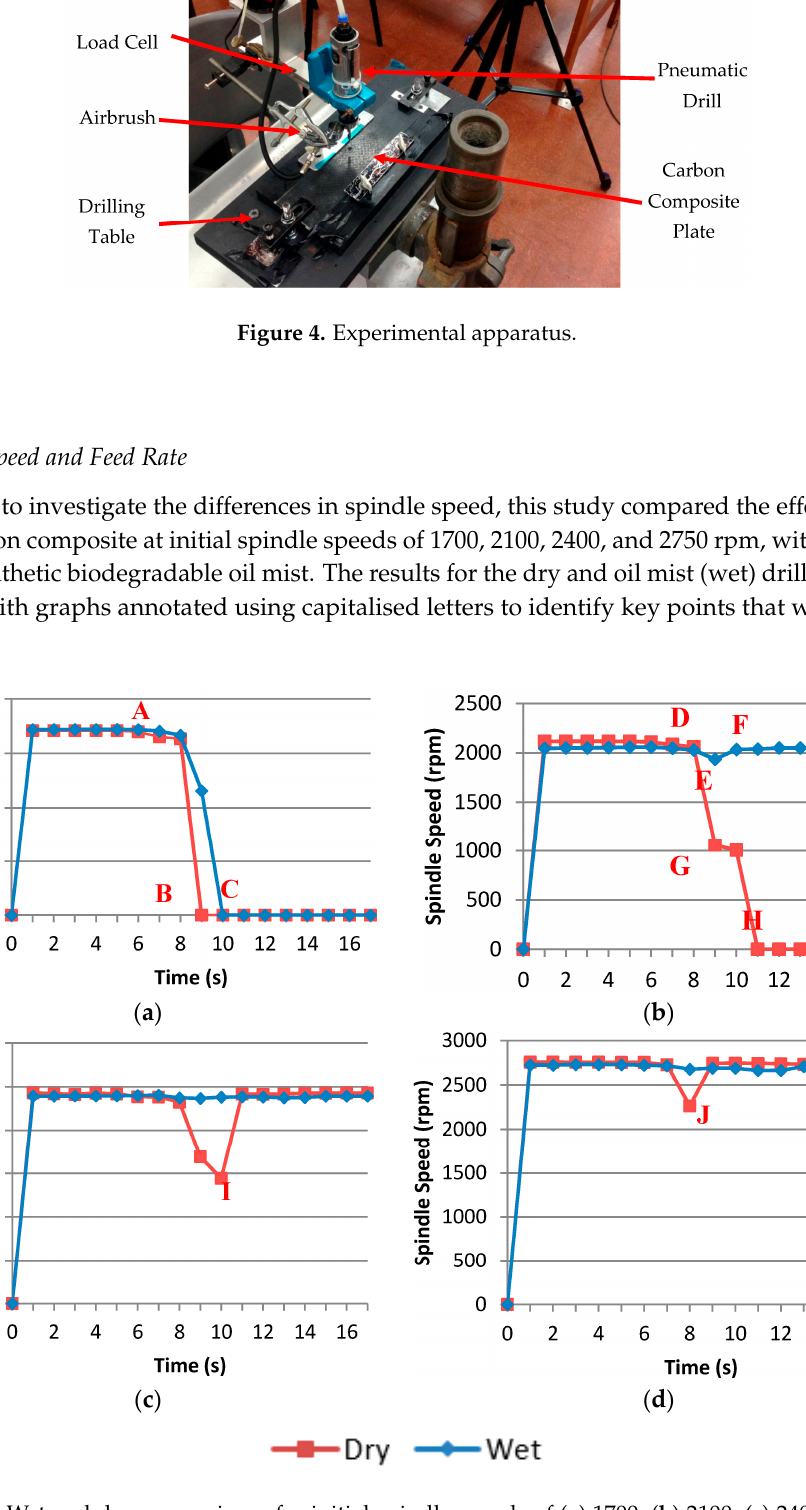
Figure 5. Wet and dry comparisons for initial spindle speeds of ( a ) 1700, ( b ) 2100, ( c ) 2400, and ( d ) 2750 rpm.